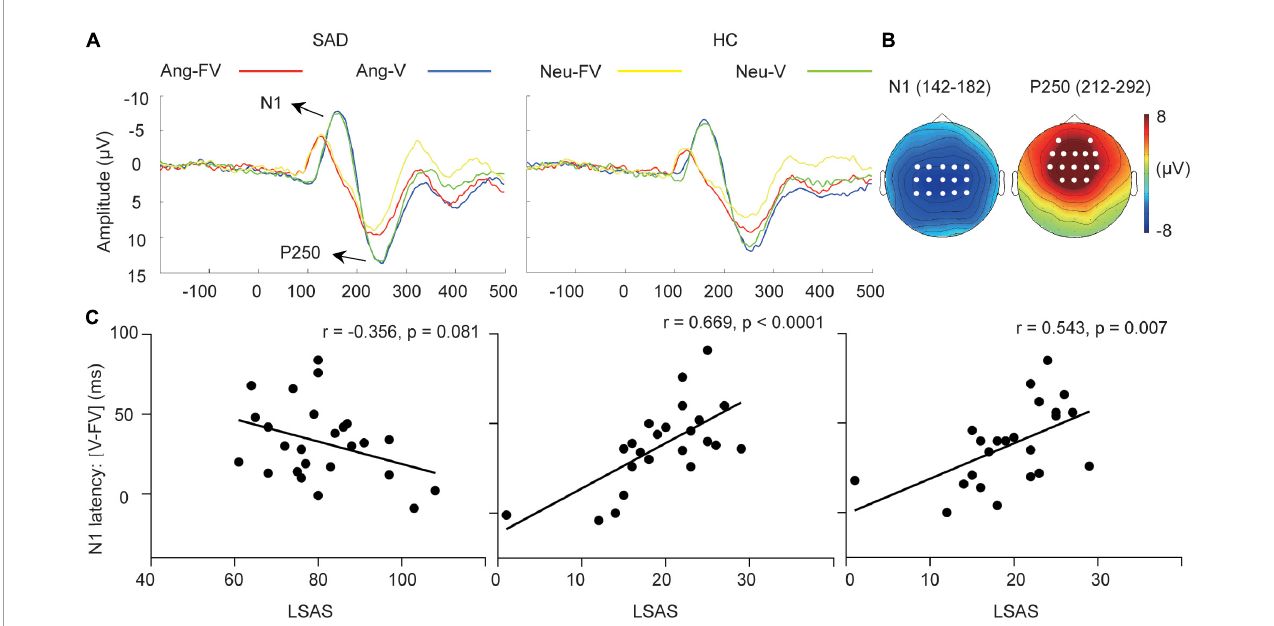
FIGURE2 Cross-modal facilitation of auditory sensitive ERPs. (A) The grand-averaged waveforms of voices and bimodal combinations in angry and neutral trials for the SAD and HC groups. Ang-V, Ang-FV: Voices and bimodal combinations in angry trials separately; Neu-V, Neu-FV: Voices and bimodal combinations in neutral trials separately. (B) The topographies of N1 and P250 in their corresponding time windows (ms) elicited by neutral voices for the SAD group as an example. The white dots indicate the representative electrodes of the components. (C) The scatter plots of the LSAS scores and the facilitation of N1 latency (V-FV) in neutral trials for the SAD group (left) and in angry (middle) and neutral trials for the HC group (right).